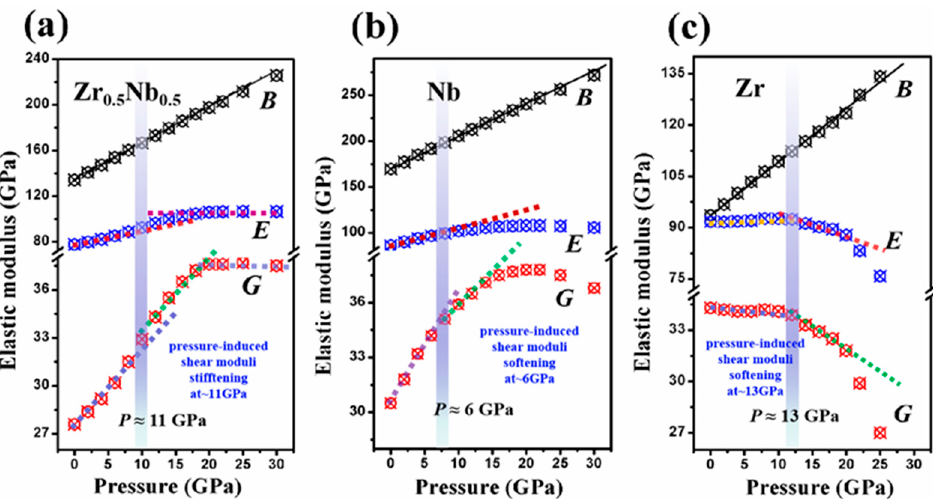
Figure 4. Theoretical prediction of bulk modulus, shear modulus, and Young’s modulus for ( a ) Zr 0.5 Nb 0.5 , Nb ( b ), and hcp -Zr ( c ) at various pressures.